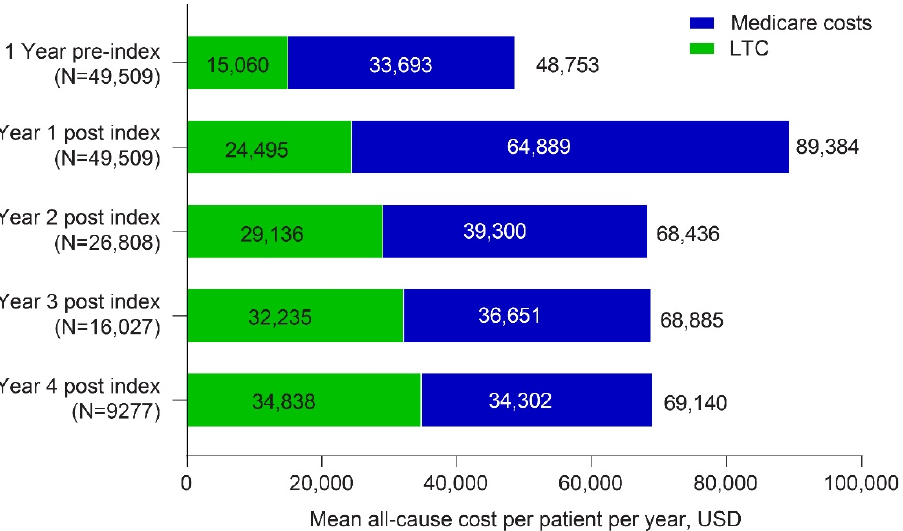
Figure 2. Annualized unweighted all ‐ cause costs per patient per year overall in Medicare and LTC in 2015 USD. Abbreviation: LTC = long ‐ term care.